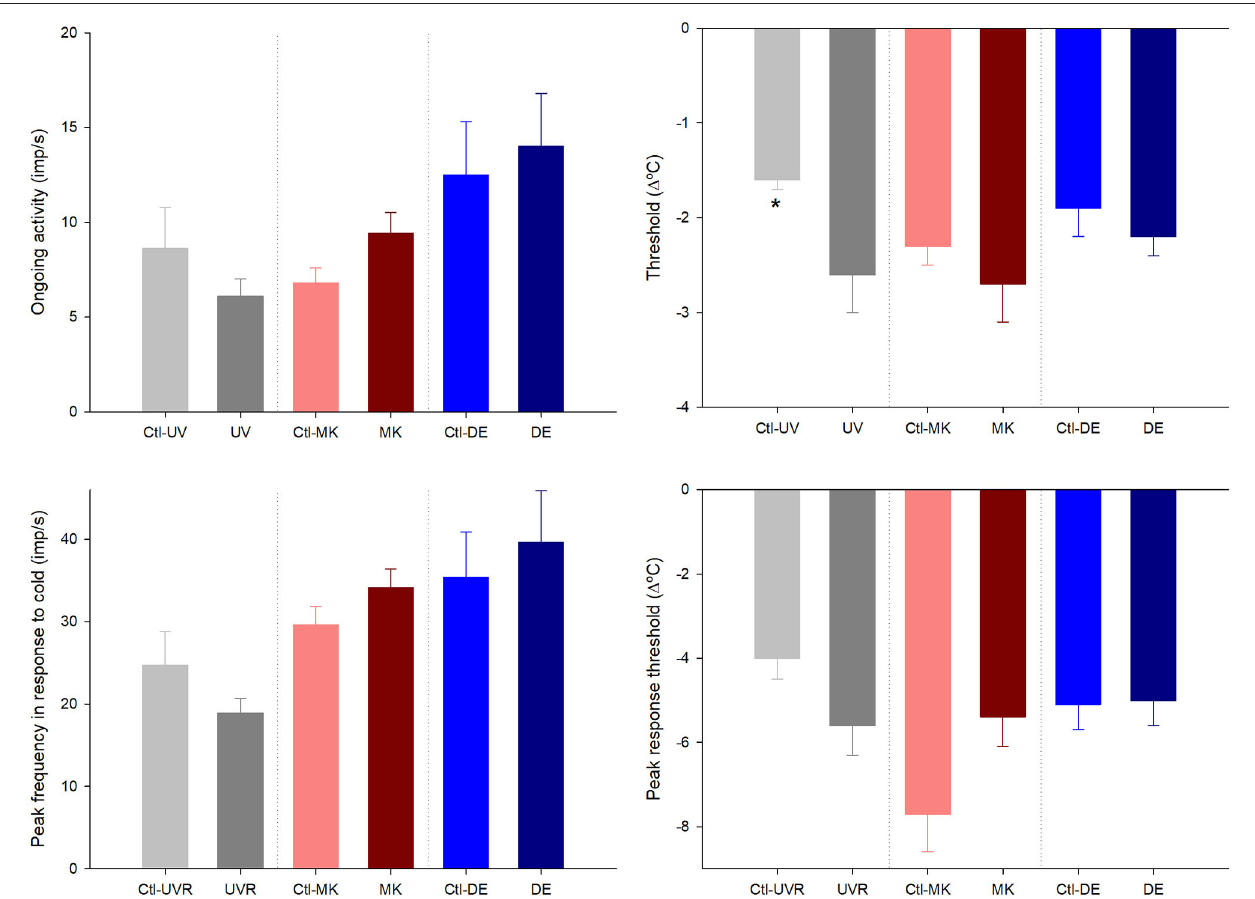
FIGURE 3 | Effects of unilateral UV radiation, microkeratome lesion, and main lacrimal gland removal on the ongoing activity and the response to cooling ramps of the cold thermoreceptor units recorded in the ipsilateral and contralateral (denoted by “Ctl” label) eyes. The data are presented as mean ± SEM. * p < 0.05, t -test or Mann-Whitney, the differences between the ipsilateral and contralateral data inside each group. ( Figure 1 ), polymodal nociceptors activity (peak frequency to cooling ramps: 30.6 ± 1.2 vs. 39.6 ± ( Figure 2 ), and cold thermoreceptors ( Figure 3 ) recorded in the 6.3 imp/s, control vs. tear-deficient; p < 0.05, t -test) of the cold eyes contralateral and ipsilateral to lacrimal gland